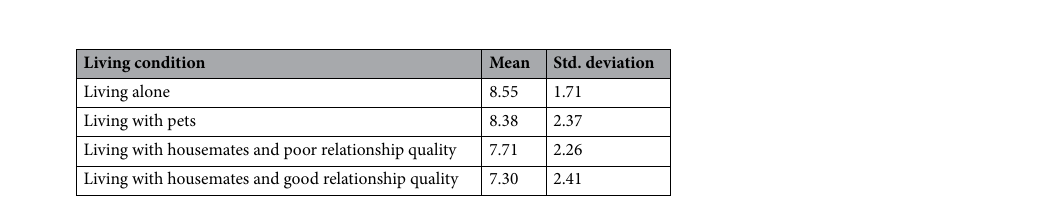
Table 3. Mean longing for touch scores for living